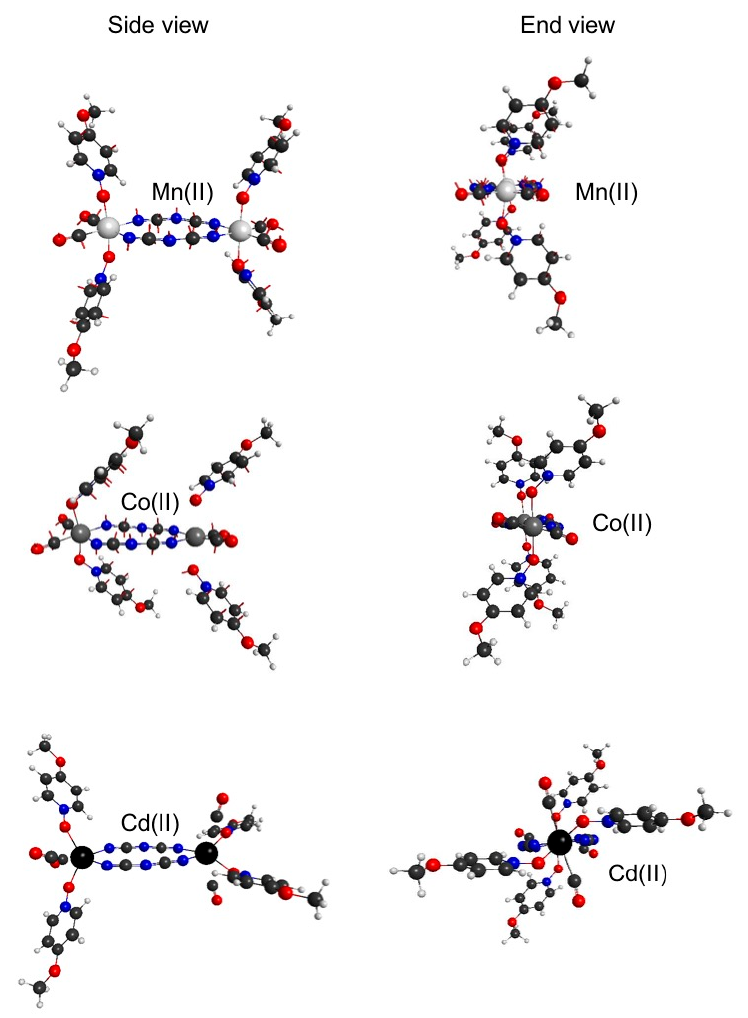
Figure 9. The global minimum energy geometries associated with the 1 , 2 , and 3 structures.